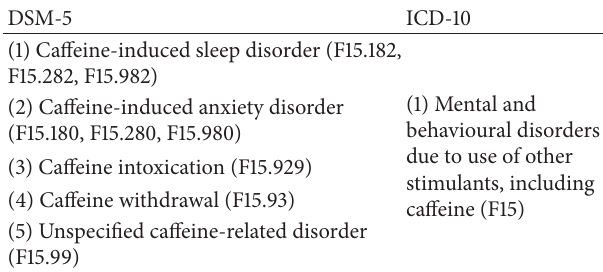
Table 1: Caffeine-related syndromes in DSM-5 and